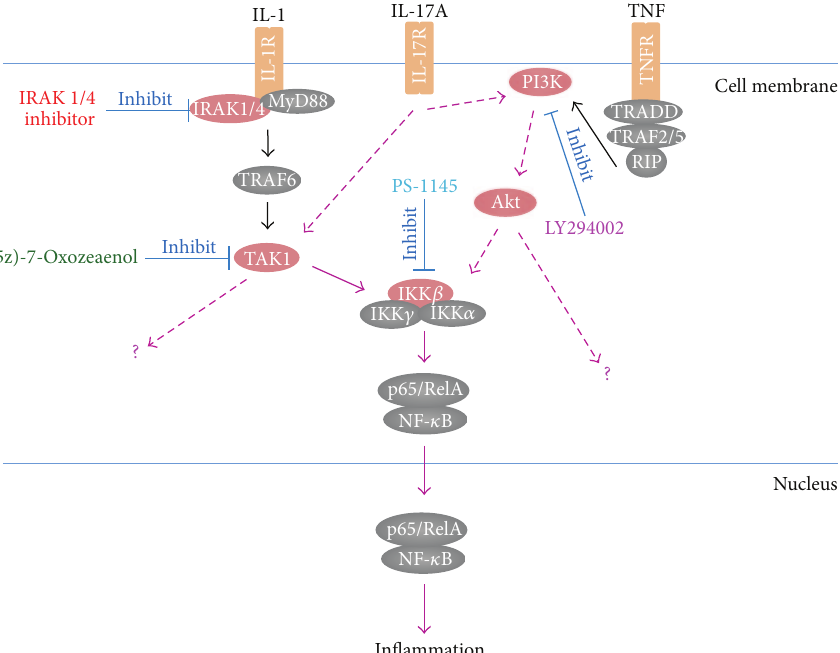
Figure 9: The signaling pathways of IL-17A in synovial fibroblasts. The scheme shows activation of the NF 𝜅 B signaling pathway through IL-17A and shared signaling with IL-1 and TNF. The purple arrows indicate signal transduction through IL-17A.